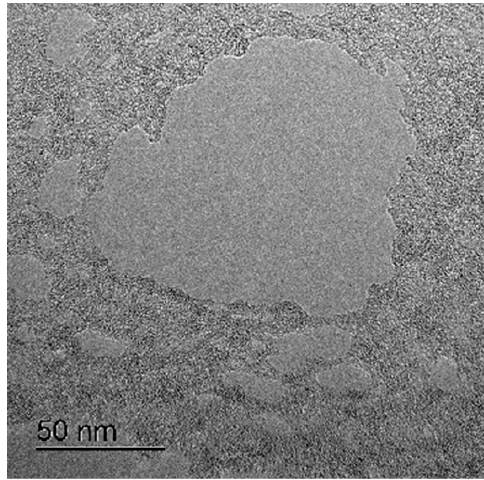
Figure 4. TEM image of an air-dried ionosilica hydrogel dispersion.